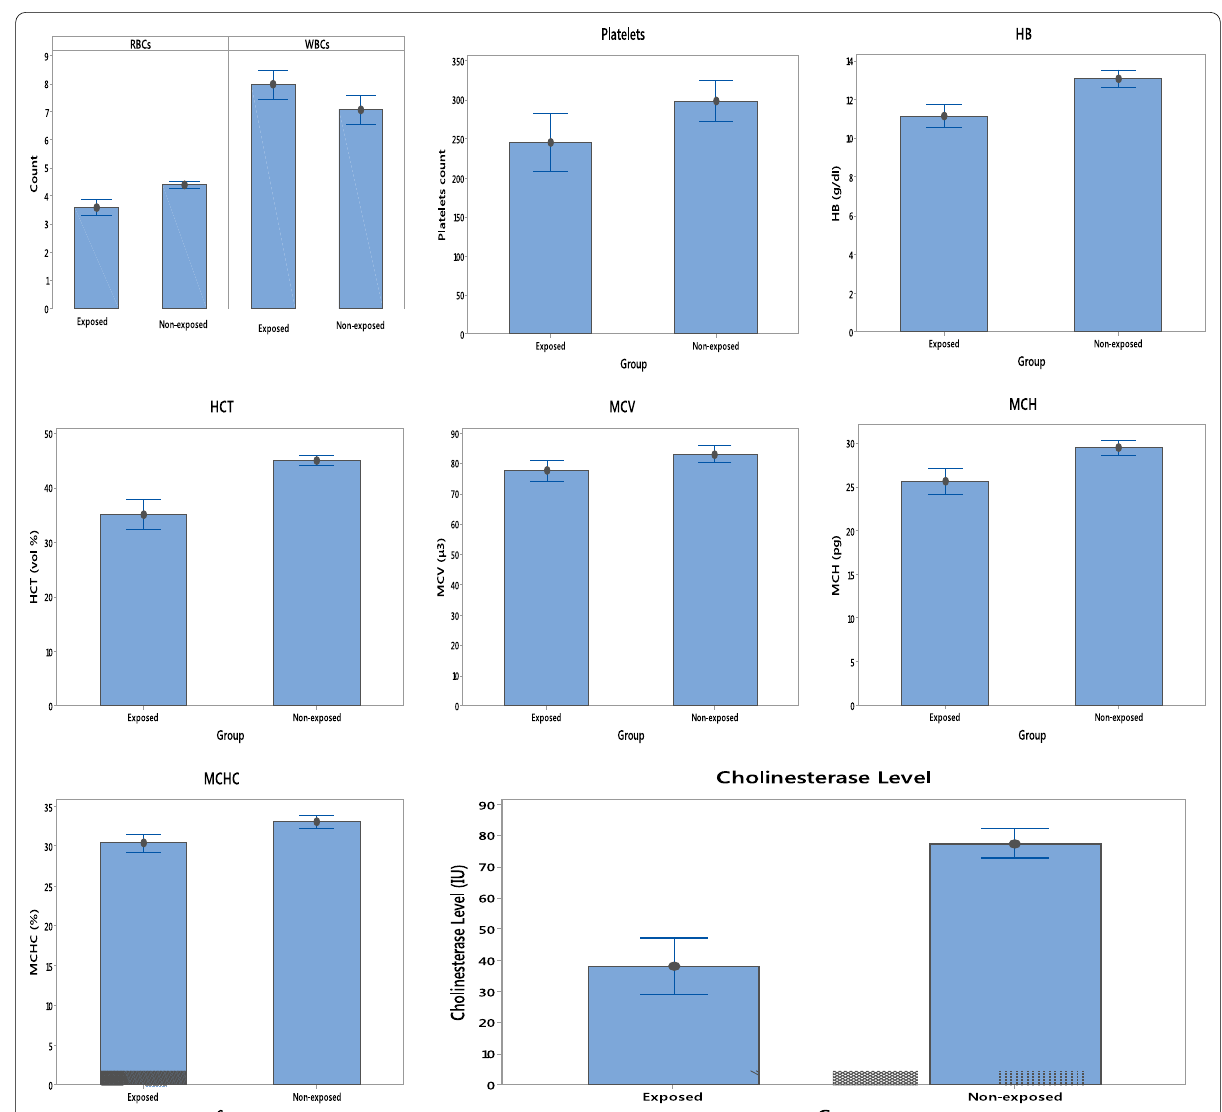
Fig. 1 Comparison between the exposed and non-exposed groups regarding the measured laboratory parameters. Significance was set at p value less than 0.05. Bars indicate the mean values with a boxplot of maximum and minimum